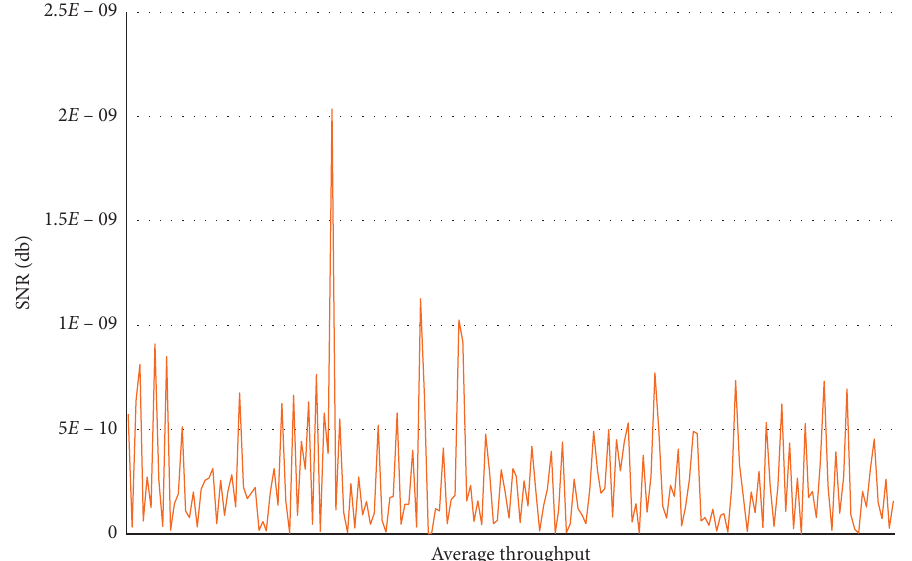
Figure 8: Average SNR concerning